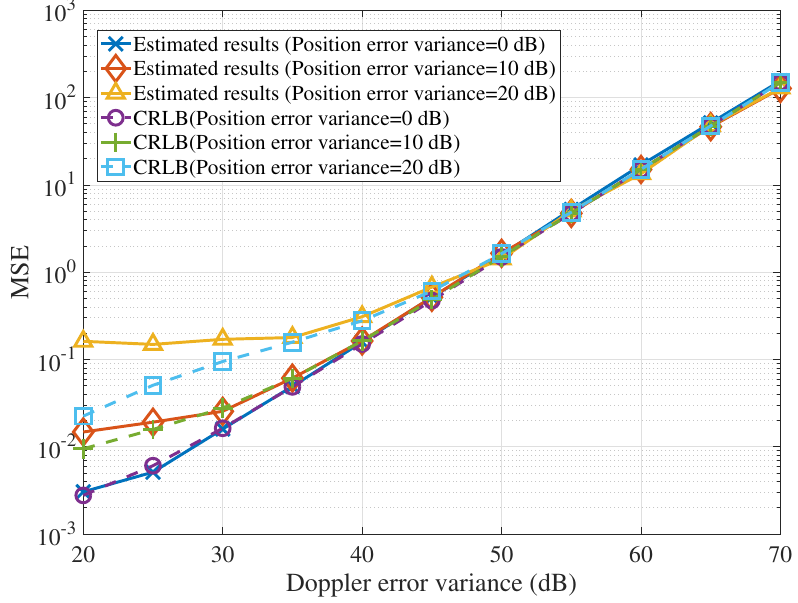
Figure 4. Target velocity estimation performance with position